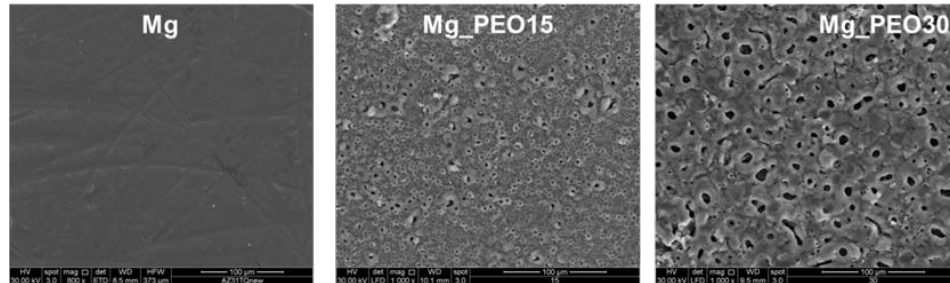
Figure 4. Morphological analysis of Mg (bare sample), Mg_PEO15 (sample coated by PEO treatment carried out at 15 mA/cm 2 ), and Mg_PEO30 (sample coated by PEO treatment carried out at 30 mA/cm 2 ).